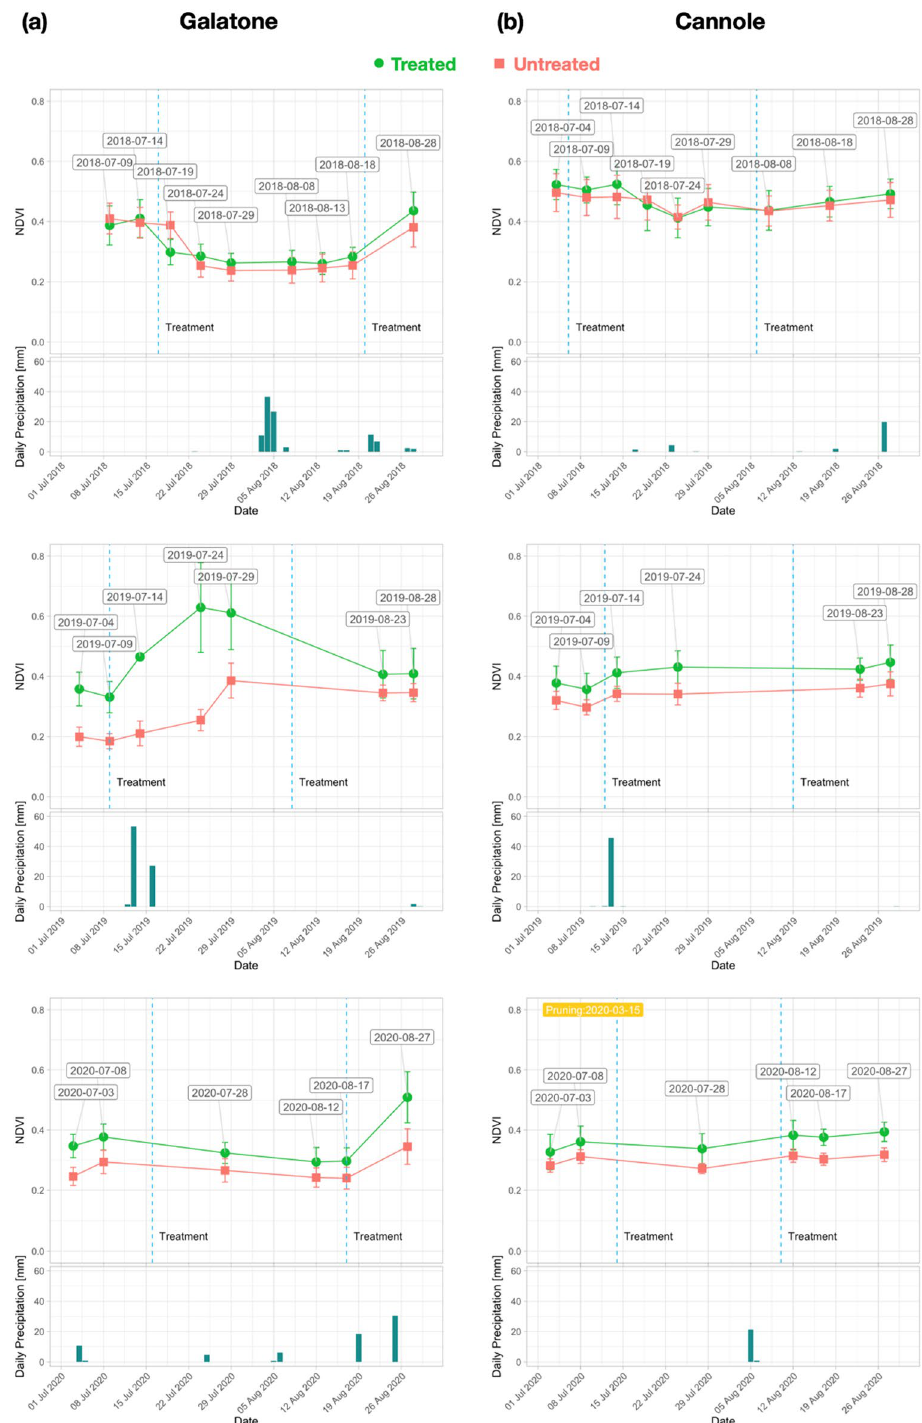
Figure 7. NDVI trend for each year (2018–2020) from S-2 date: ( a ) Galatone; ( b )